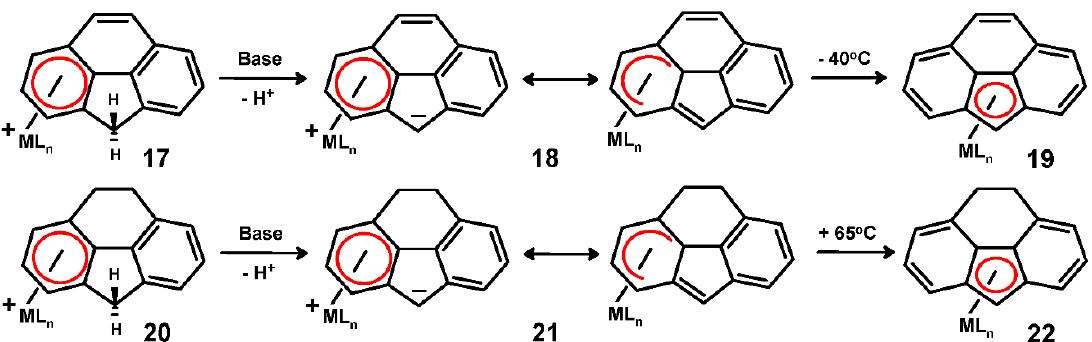
Figure 4. The calculated trajectory of an η 6 to η 5 haptotropic shift taken by an Mn(CO) 3 tripod via an η 3 transition state apparently stabilised by development of aromatic character in the (shaded) naphthalene fragment.